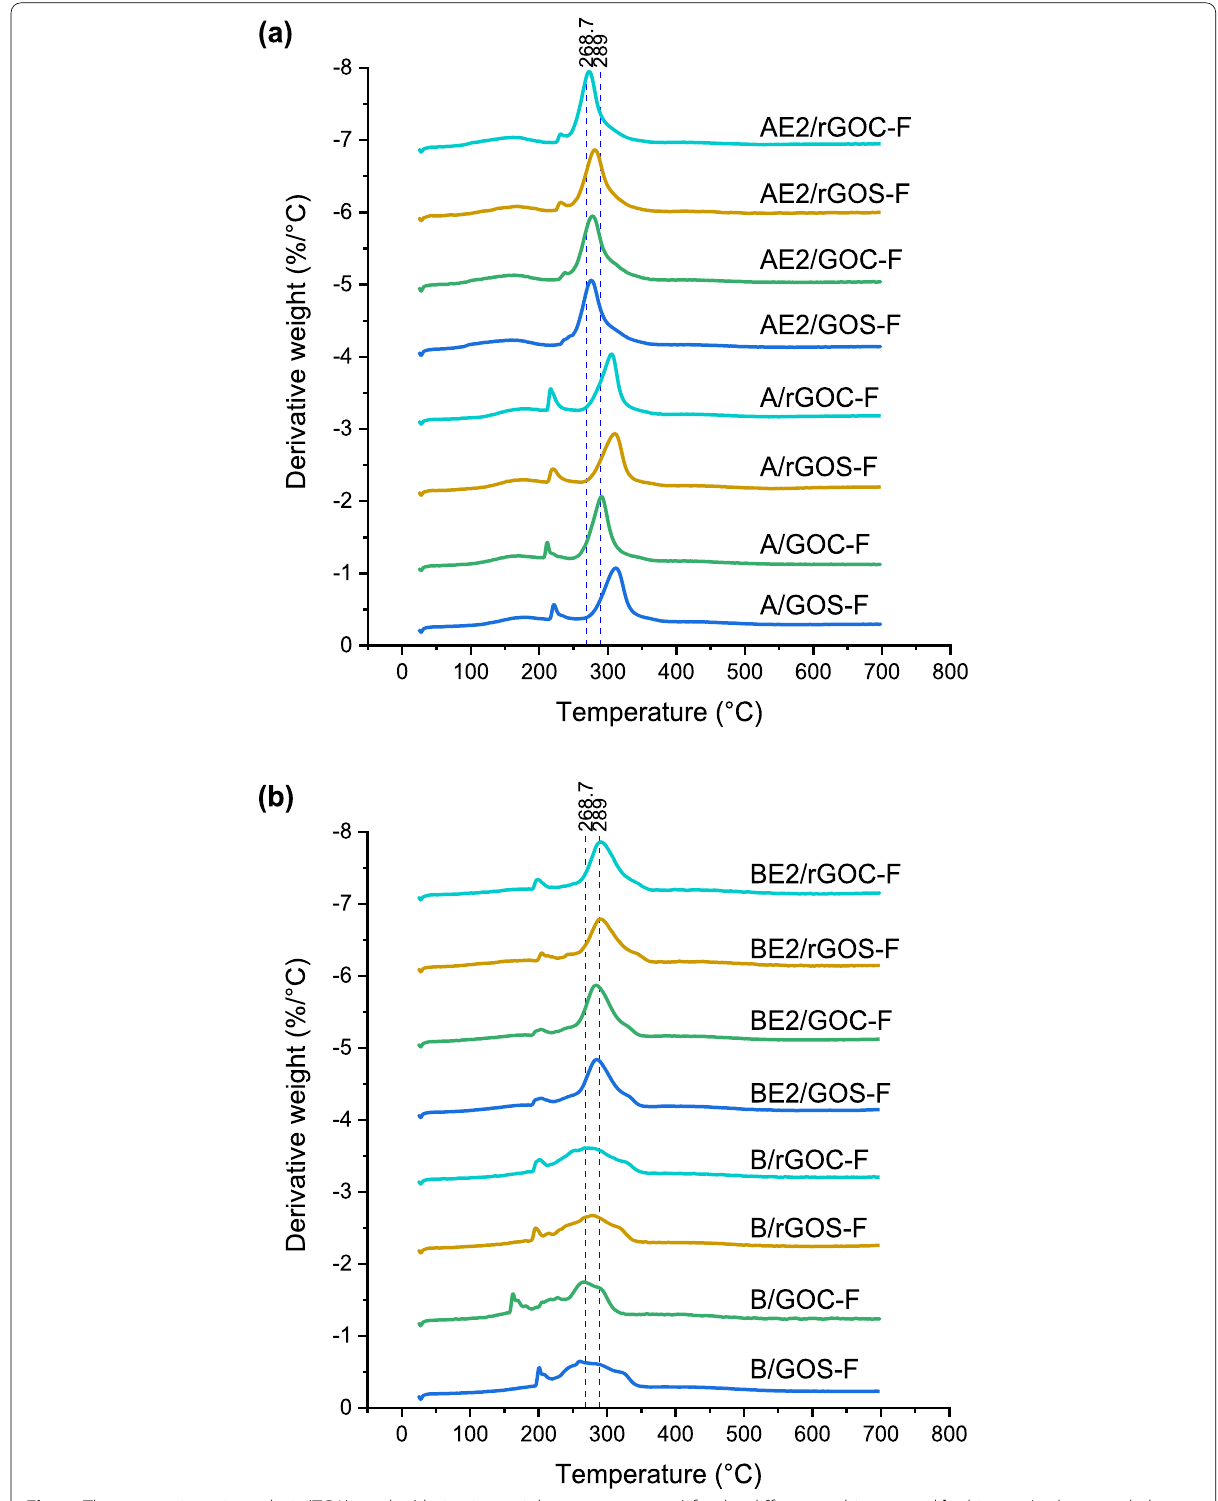
Fig. 4 Thermogravimetric analysis (TGA) results (derivative weight vs. temperature) for the different a chitosan and b chitosan/carboxymethyl cellulose (CMC)-based nanocomposite films. The reference lines denote the major peak temperatures of B/GO-F (269 °C) and A/GO-F (289 °C), respectively